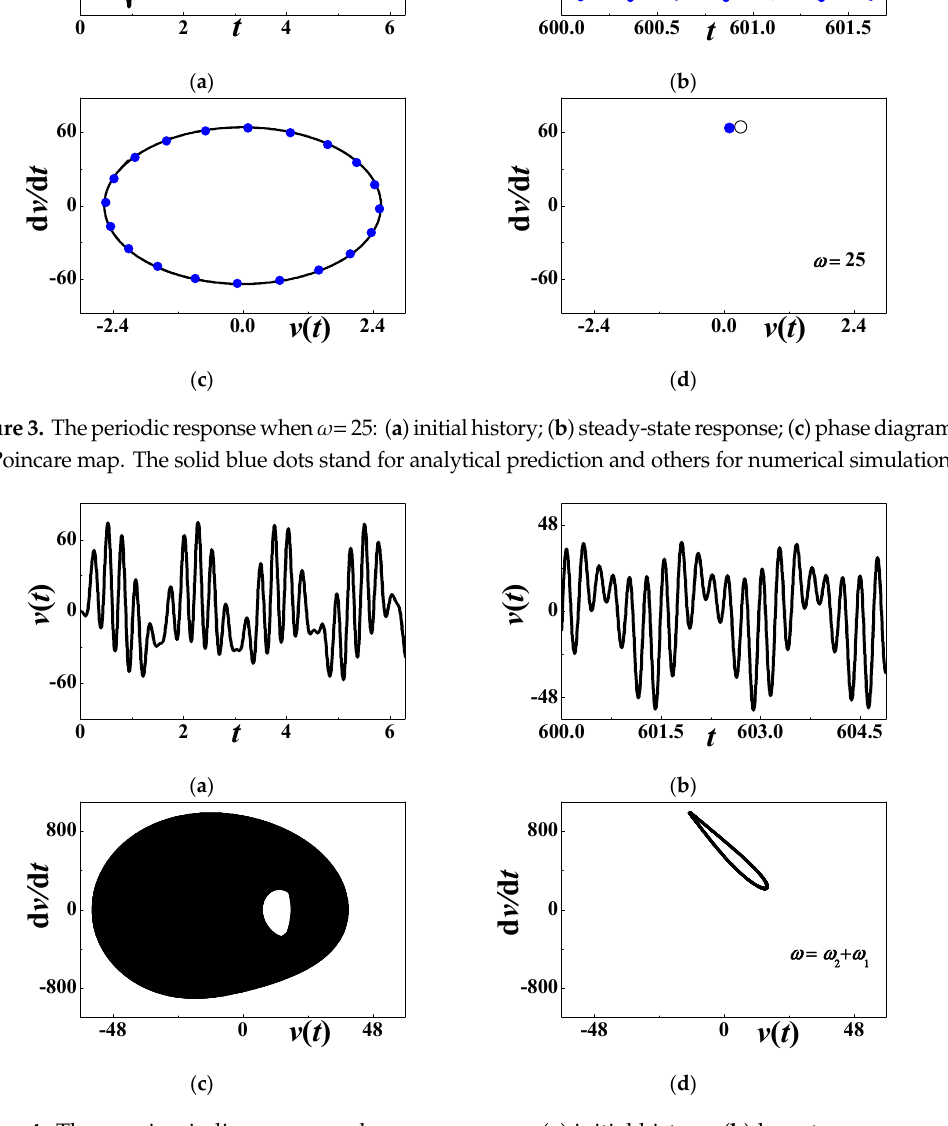
Figure 4. The quasiperiodic response when ω = ω 2 + ω 1 : ( a ) initial history; ( b ) long-term response; ( c ) phase diagram; ( d ) Poincare map.